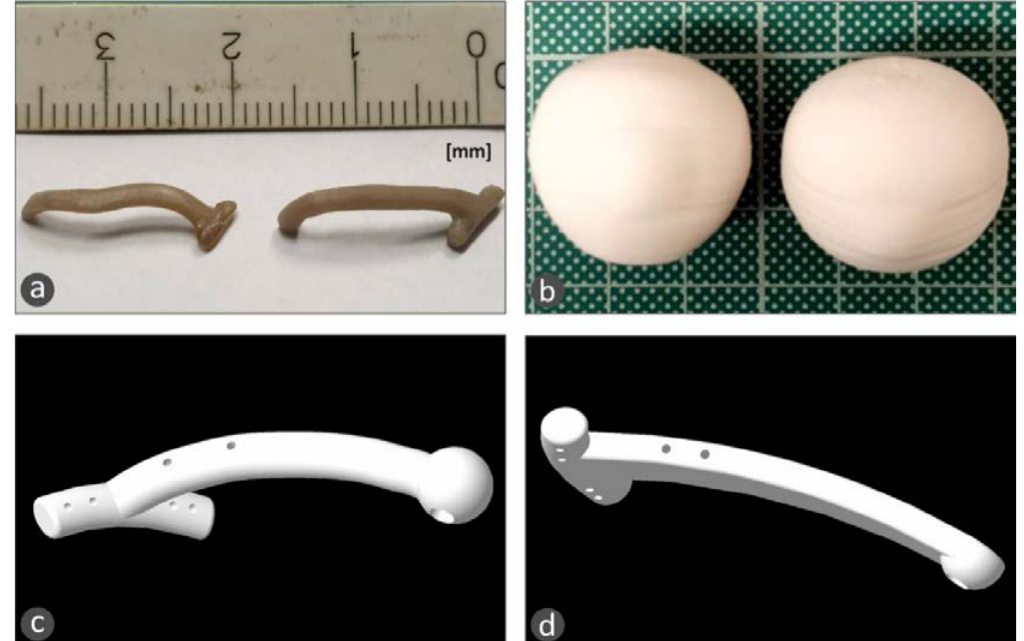
Figure 7. ( a ) 3D-printed customized macular buckle with polyether ether ketone (PEEK) material; ( b ) 3D-printed patient’s eye models with polylactic acid (PLA) material; ( c , d ) typical shapes of